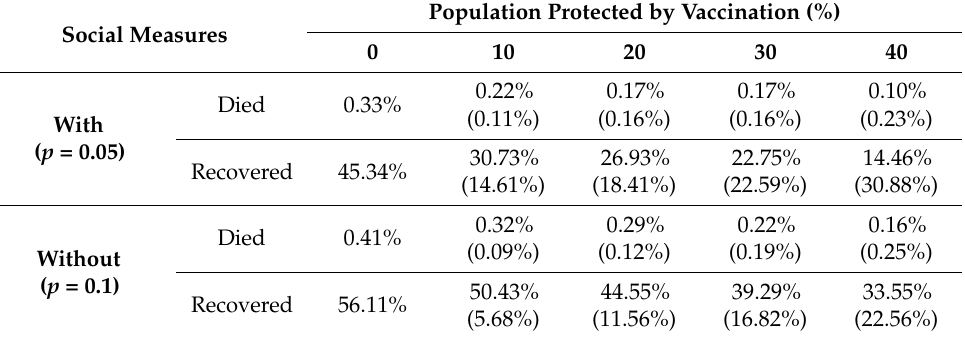
Table 3. Average number of expected people who died or recovered following infection depending on the level of population protection provided by vaccination. Percentages are with respect to population size (46,014,554 people). Social